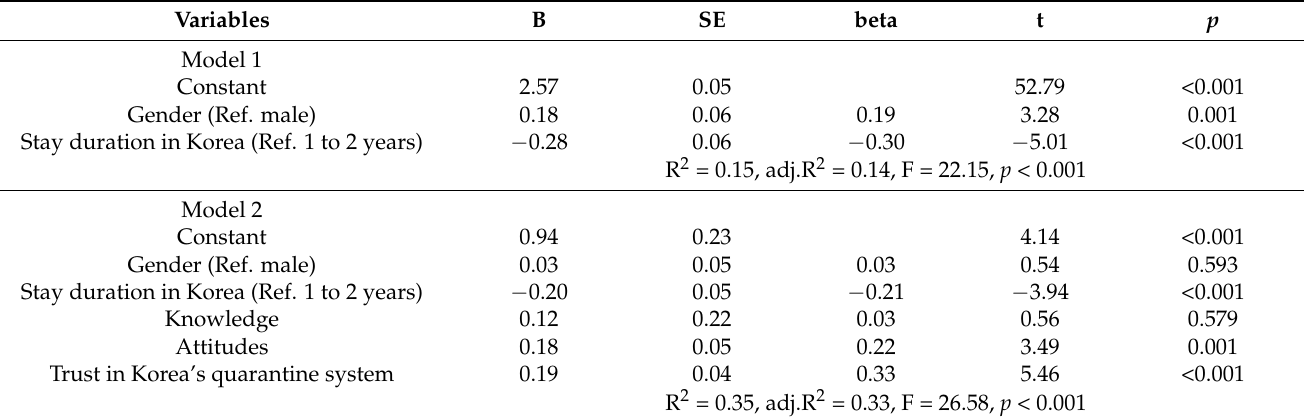
Table 5. Factors influencing preventive practice against COVID-19 ( N =